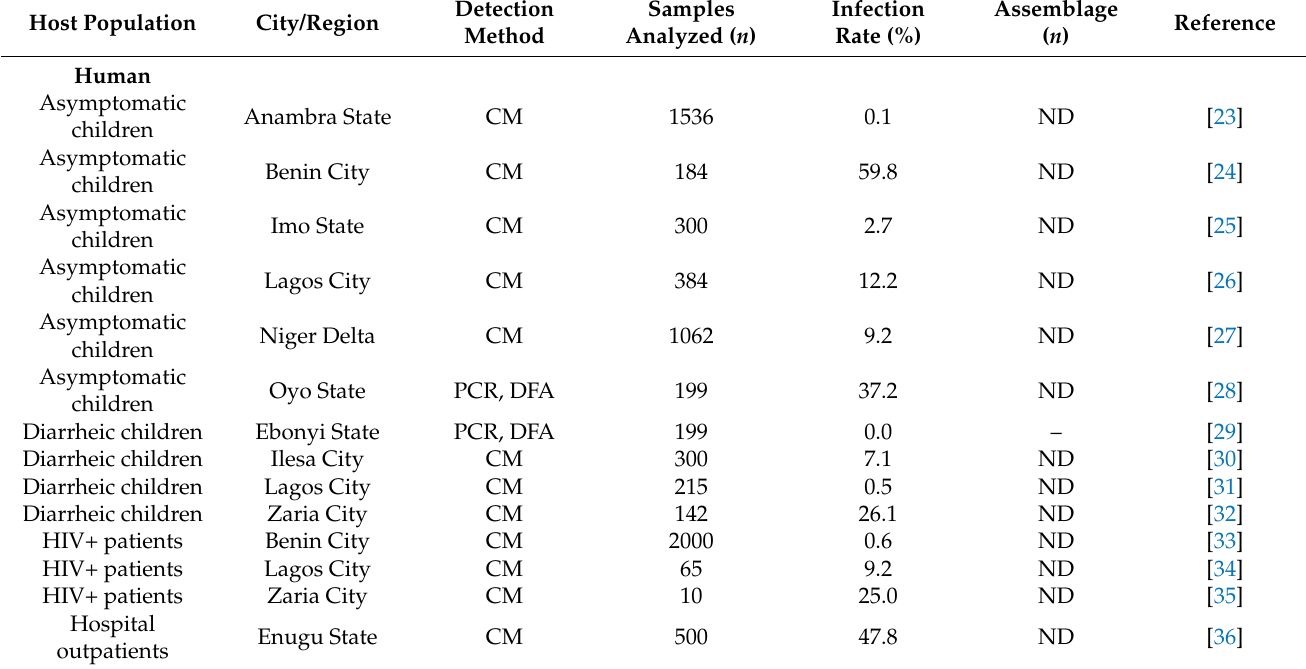
Table 1. Occurrence and genetic diversity of Giardia duodenalis in human and animal hosts in Nigeria,